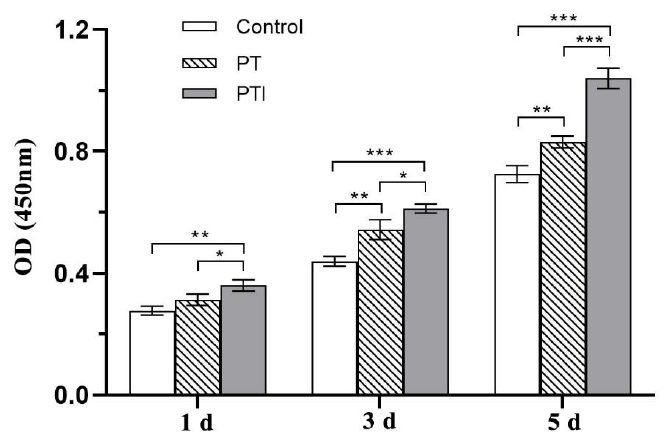
Figure 6. Cell proliferation activity of each group after coculture with scaffolds. * p < 0.05, ** p < 0.01, *** p <